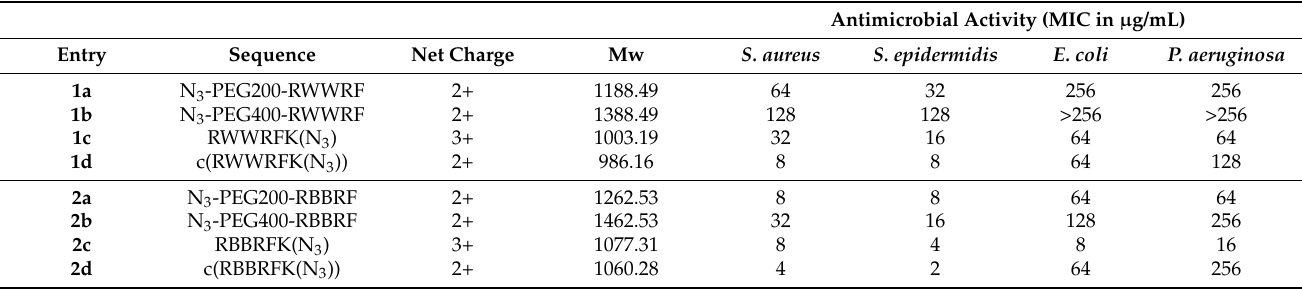
Table 1. Antimicrobial activity of eight clickable peptides against four selected bacterial reference